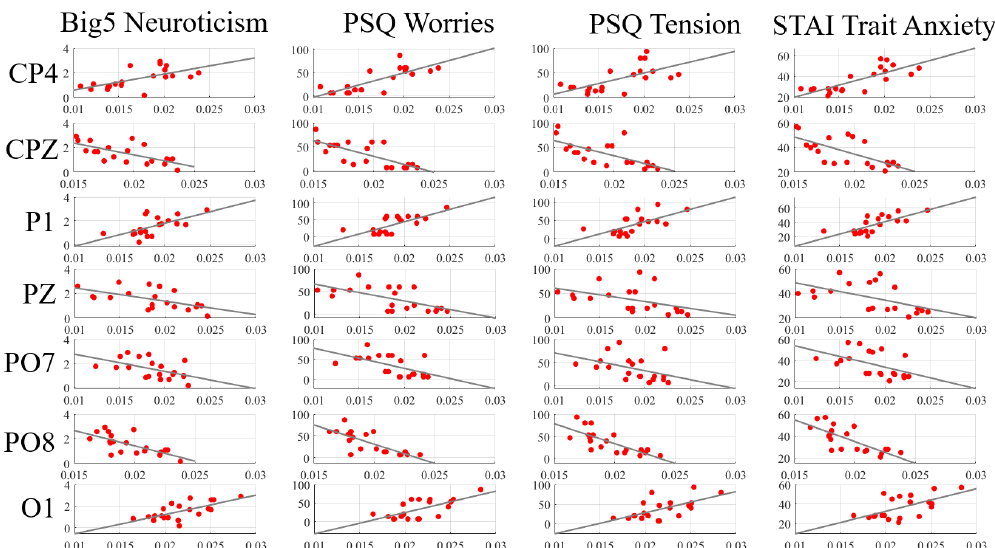
Figure A15. Eyes-Open (EO) setting. Spearman correlation between participants’ responses to questionnaires and their cumulative TEs. These TEs correspond to EEG channels whose cumulative TEs were significantly different between HIGH versus LOW stress-susceptible participants. The figure shows the second half of these channels: CP4, CPZ,P1, PZ, PO7, PO8, and O1. The first half of these channels are shown in Figure A14. The channels are marked along the vertical axis of each subplot in the figure. The questionnaires are marked on the top of each subplot and along their horizontal